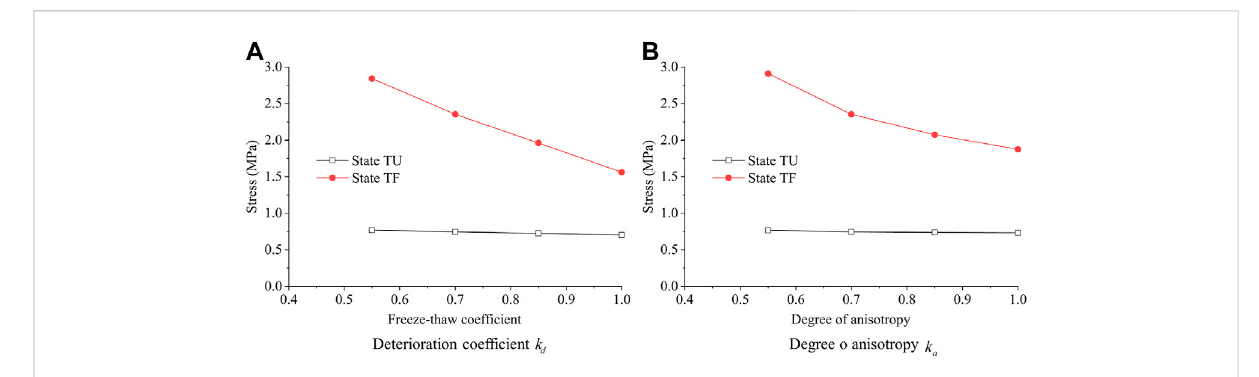
FIGURE 12 In fl uence of deterioration coef fi cient k d and degree of anisotropy k a on P l